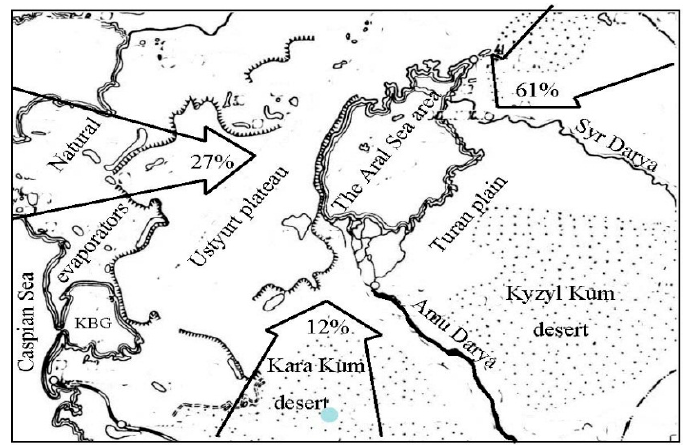
Figure 3. Prevailing wind directions in the Aral Sea zone and their recurrence [47,51].